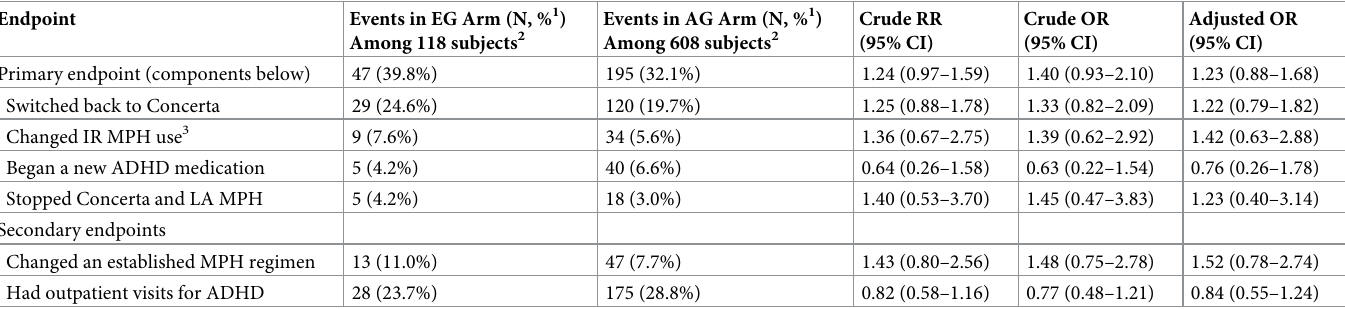
Table 5. Crude risk ratios, crude odds ratios, and adjusted odds ratios for primary endpoint, components of primary study endpoint, and two secondary